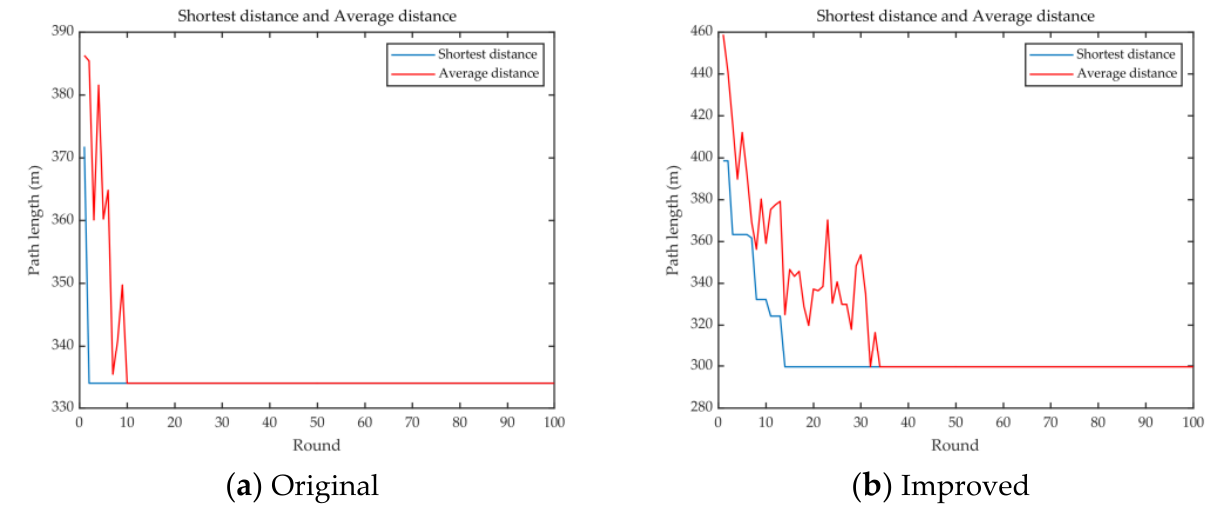
Figure 15. Comparison between original and improved.